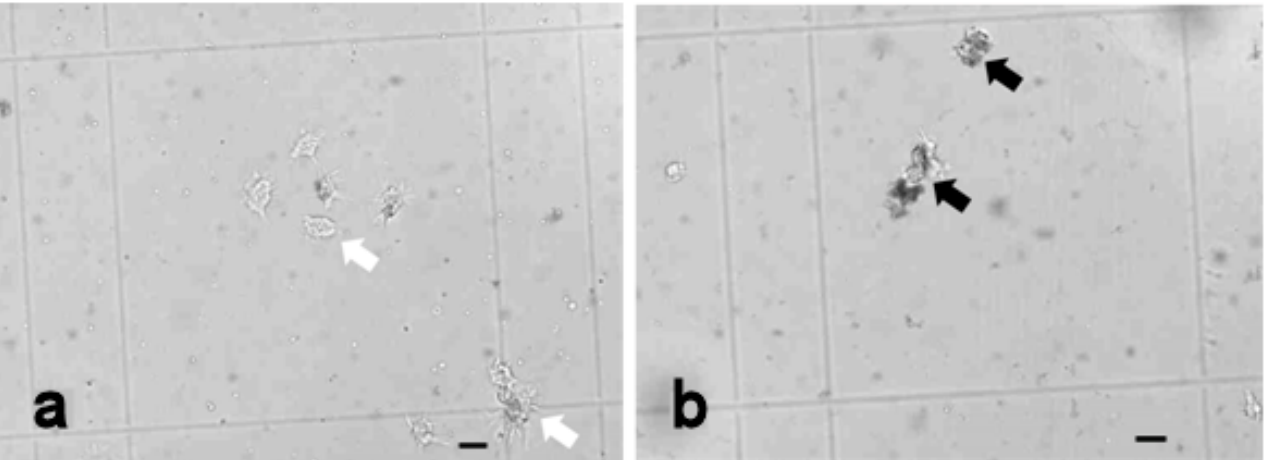
Figure 6. The number of vacuolised cells mL − 1 (mean ± SD) after 24, 48, and 72 h for the control mussels (0 mg L ‐ 1 ) and mussels exposed to 0.1 mg L − 1 (LOW), 1.0 mg L − 1 (MID), and 10 mg L − 1 (HIGH) PMMA microparticles of ( a ) 10 μ m diameter and ( b ) 50 μ m diameter. Statistical significance is indicated at the levels * p < 0.05, ** p < 0.01. Similar values were found for the experimental treatments with 50 μ m microparticles. Over the course of 72 h the number of vacuolised cells increased for each individually tested microparticle concentration (Figure 6b). Moreover, the number of vacuolised cells was also noted to be a function of microparticle concentration, with the 0.1, 1, and 10 mg L − 1 concentrations increasing the average vacuolisation of the cells to about 3 × 10 6 , 4 × 10 6 , and 4 × 10 6 cells mL − 1 , respectively, from the control value of about 1 × 10 6 cells mL − 1 . The stability of the lysosomal membrane of the haemocytes was investigated each day and no statistically significant differences from the controls were found up to the 2 h point (data not shown). While the test is usually run over the course of 2 h, we allowed the test to continue to 3 h, and at this test time point the haemocytes from the mussels exposed to the highest concentration of 10 μ m particles indicated that less than 50% of